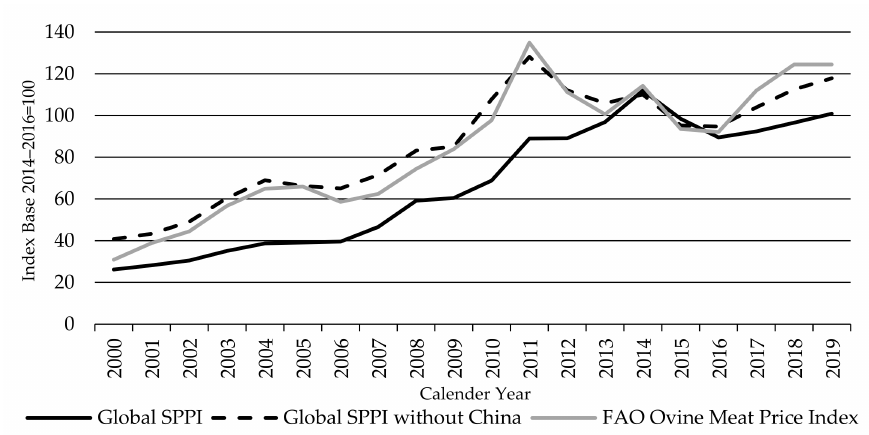
Figure 17. The Global Sheep Meat Producer Price Index SPPI, the Global Sheep Meat Producer Price Index SPPI (without China), and the FAO Ovine Meat Price index, source: own illustration, FAO index